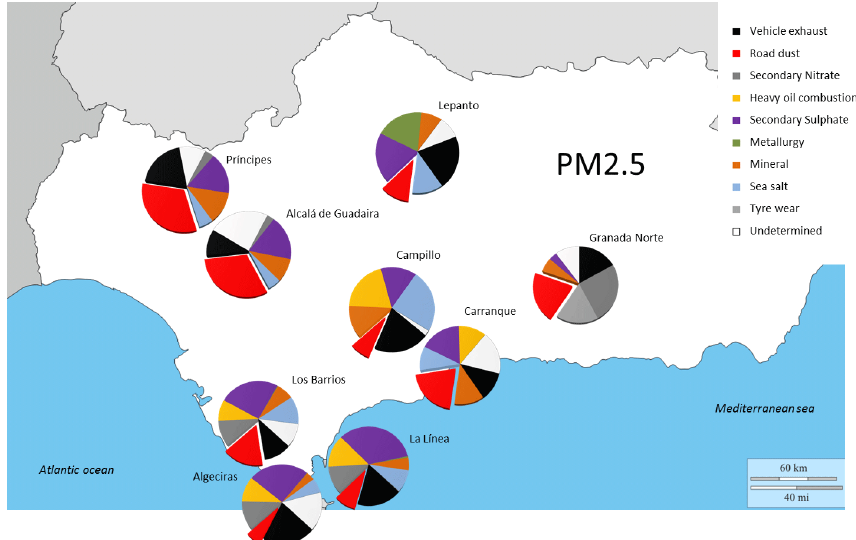
Fig. 5. Pie chart of average source contributions to PM 2 . 5 levels observed at the 9 stations in Andalusia.